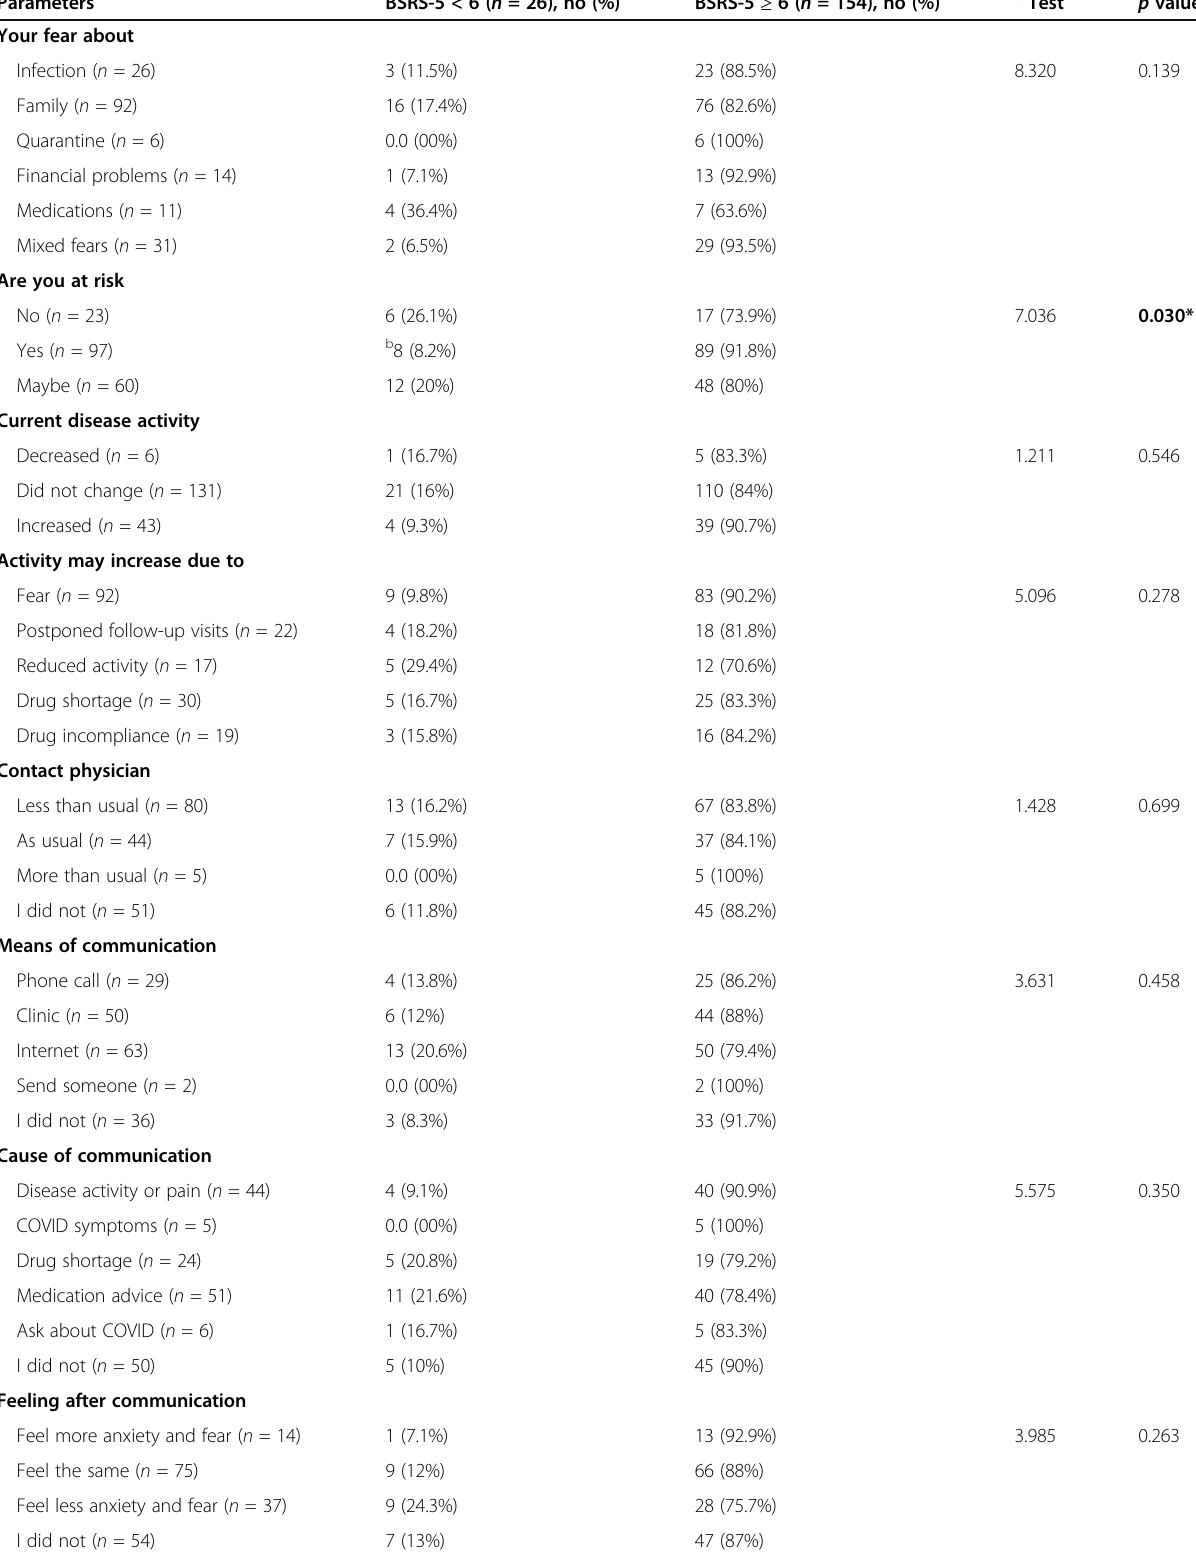
Table 6 Relation between parameters and patients mental health degree ( n =